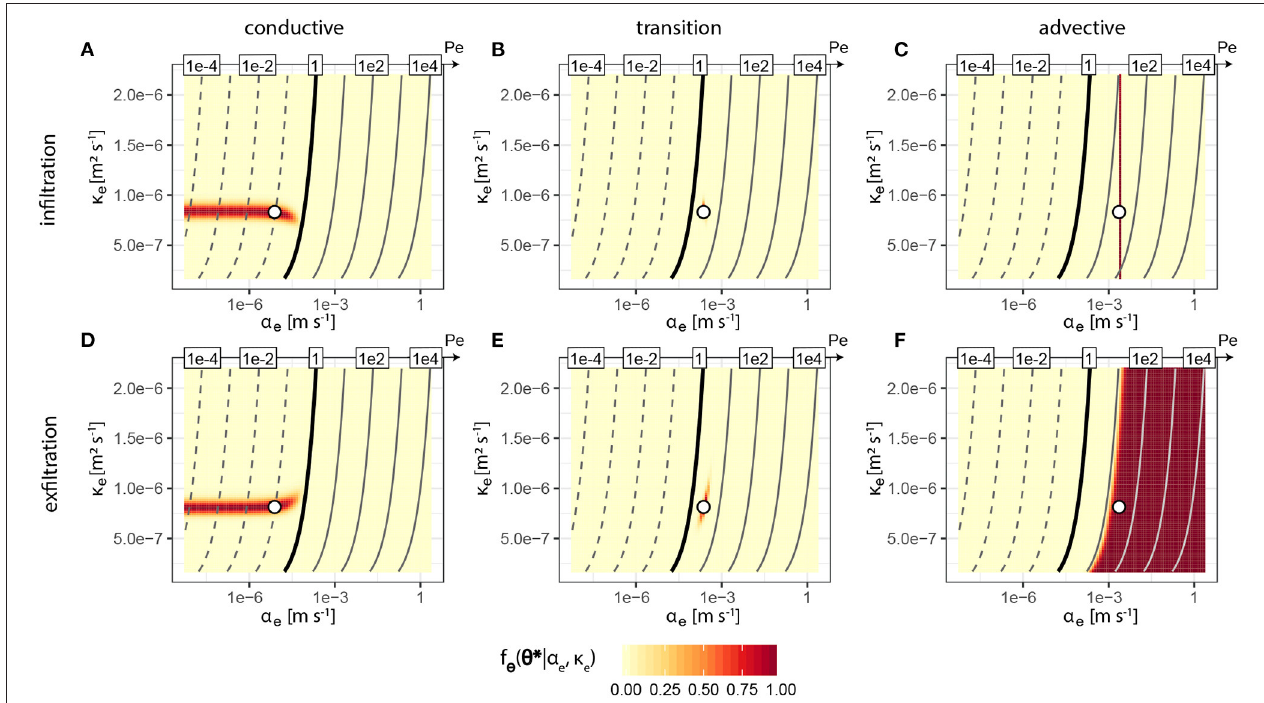
FIGURE 3 | Likelihood values as a function of advective effective parameter α e and conductive effective parameter κ e (Equation 7), calculated from synthetic observed time series θ ∗ (section 2.2.3). Panels a-f refer to the hydrological and thermal regimes as defined in Table 4 . In each figure, values are normalized from 0 to 1 so that the same color scale can be applied, the x-axis is on a log-scale. The white dot represents the true parameters used to generate θ ∗ . The contour lines signify constant values of Peclet number (thick black: Pe = 1, dashed gray: Pe < 1, solid gray: Pe > 1, one line per unit on the decimal logarithmic scale).